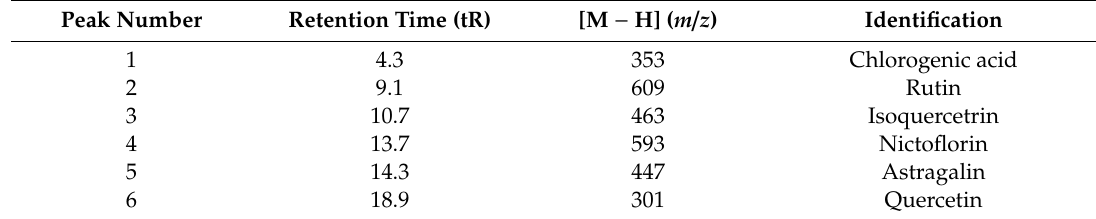
Table 1. Peak assignments of six phenolics compounds.